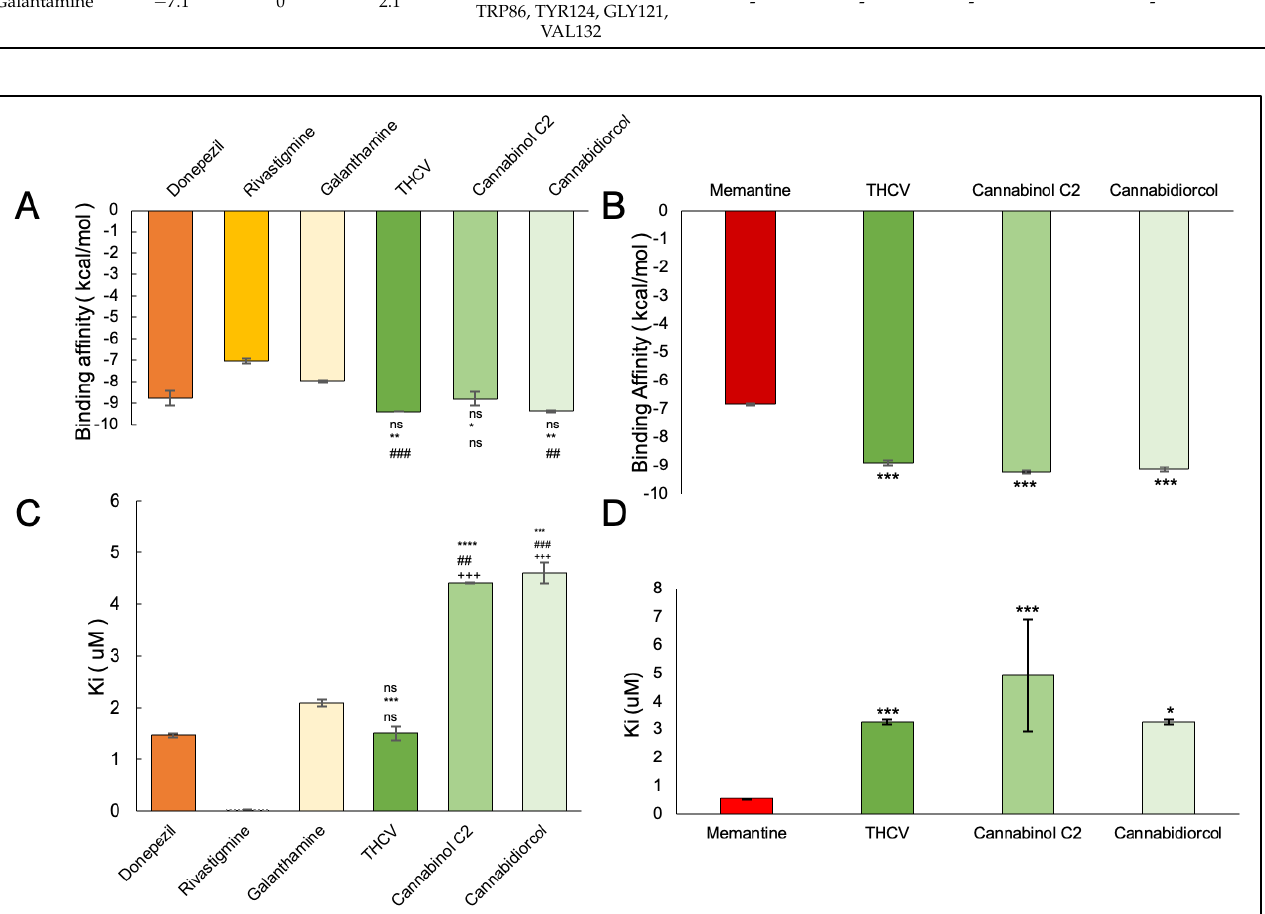
Figure 3. Graphical representation showing comparison of binding affinity and inhibition constant among ( A , C ) AChE inhibitors (Donepezil, Rivastigimine, Galantamine) and THCV, Cannabinol C2 and Cannabidiorcol ( B , D ) Butyrylcholinesterase inhibitors (Memantine) and THCV, Cannabinol C2 and Cannabidiorcol (* p < 0.1, ** p < 0.01, *** p < 0.001) and values are mean ± standard deviation where p * (Donepezil), p # (Rivastigmine), p + (Galantamine) and p * (Memantine) .